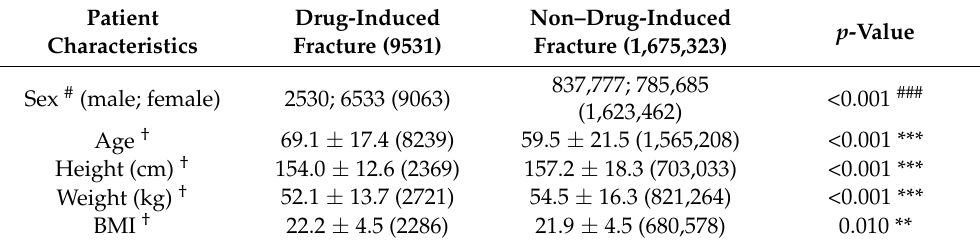
Table 2. Comparison of patient characteristics between drug-induced and non–drug-induced fractures.